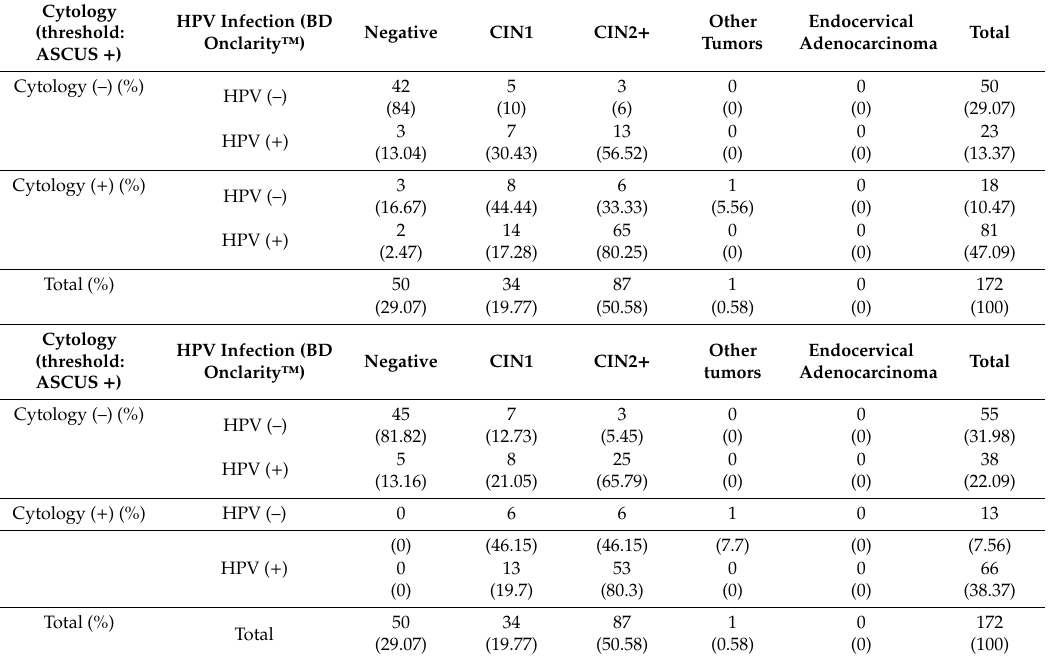
Table 11. Histological diagnosis in the BD Onclarity ™ HPV assay